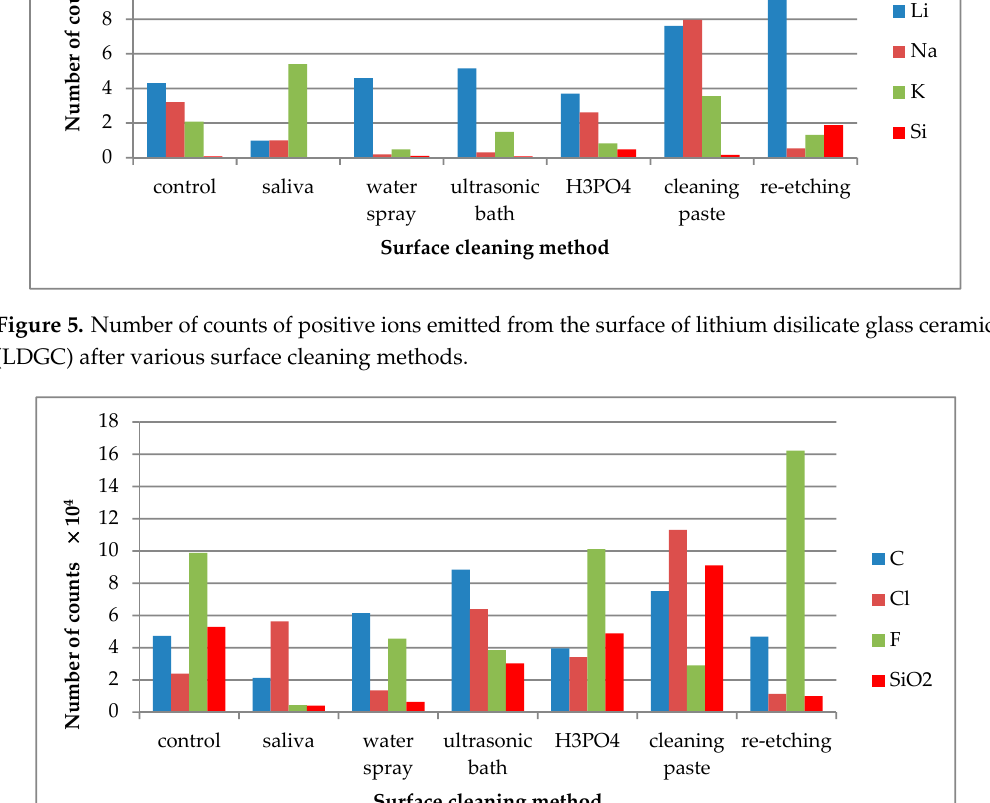
Figure 6. Number of counts of negative ions emitted from the surface of lithium disilicate glass ceramic (LDGC) surface after various surface cleaning methods.